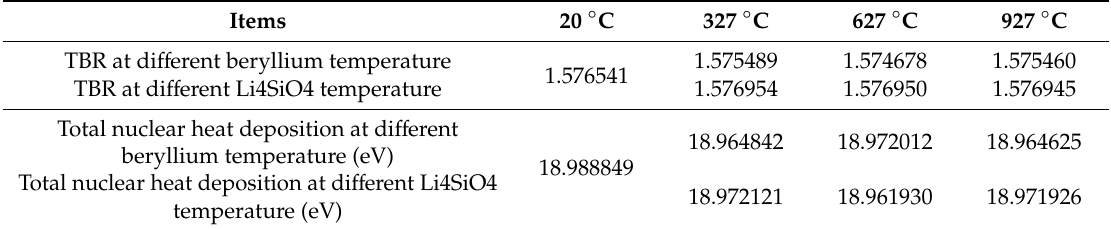
Table 8. Neutronics results of the HCSB blanket without considering the S ( α , β ) data at di ff erent materials temperatures.